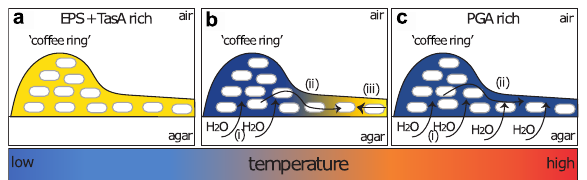
Fig. 6 Schematic model of matrix production as a function of density and temperature. The `coffee ring' is the initial region of higher density that is formed after deposition onto the agar surface. a Low temperatures produce a bio fi lm matrix rich in EPS and TasA (yellow). b Intermediate temperatures induces PGA production (blue) and (i) concomitant fl uid extraction from the agar that originates in the high density region. (ii) The fl uid propagates towards the center where (iii) EPS and TasA matrix production halts its advance. c High temperatures results in a PGA rich matrix that induces (i) fl uid extraction that (ii) covers the entire bio fi lm resulting in a mucoid